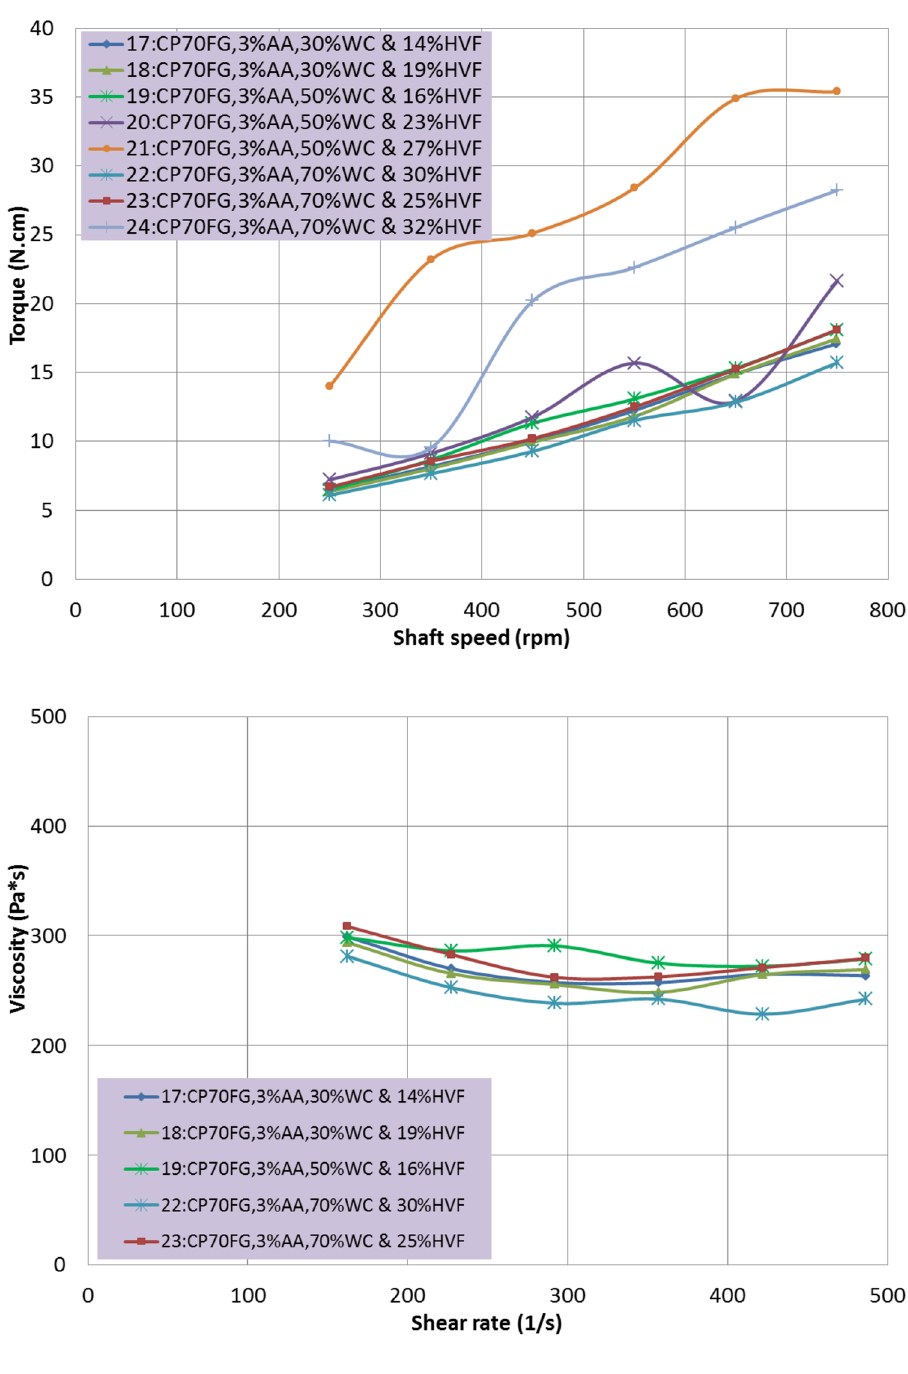
Fig. 17 Average torque values collected from Zone IV for Crystal Plus 70FG tests. AA anti-agglomerant, WC watercut, CP70FG Crystal Plus 70FG,